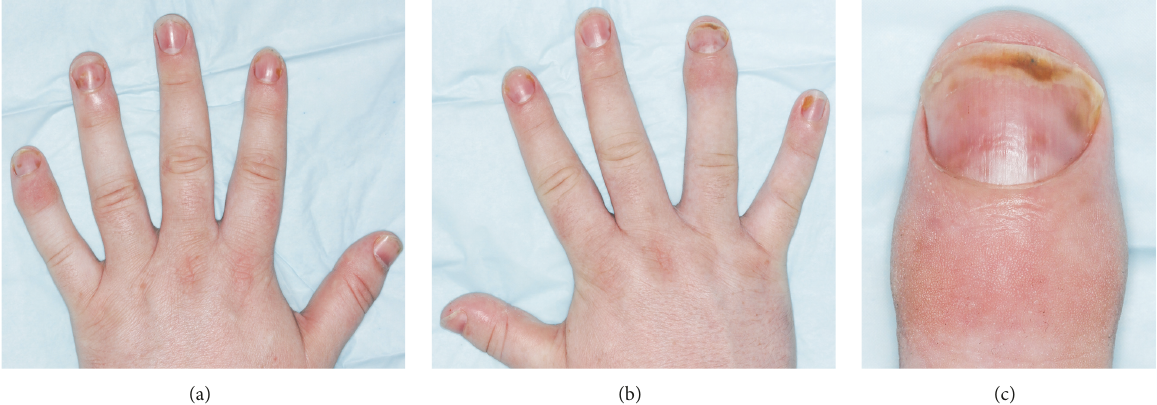
Figure 1: Swelling with redness of the distal interphalangeal (DIP) joints of the left (a) and right (b) hand. Predominantly the right index and left little finger are affected. Psoriatic nail changes with oil drops and distal onycholysis occurred on almost all fingernails. (c) Close-up view of DIP on the right hand.